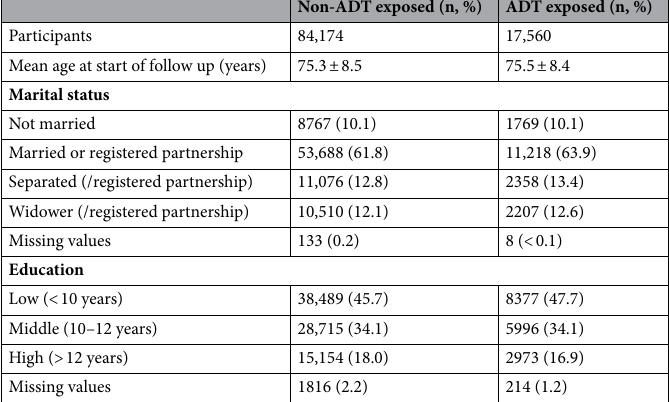
Table 1. Characteristics of men exposed or not exposed to androgen deprivation therapy (ADT) in Prostate Cancer data Base Sweden. Continuous variables expressed as mean ± standard deviation. Categorical variables expressed as frequencies (n) with percentages (%).